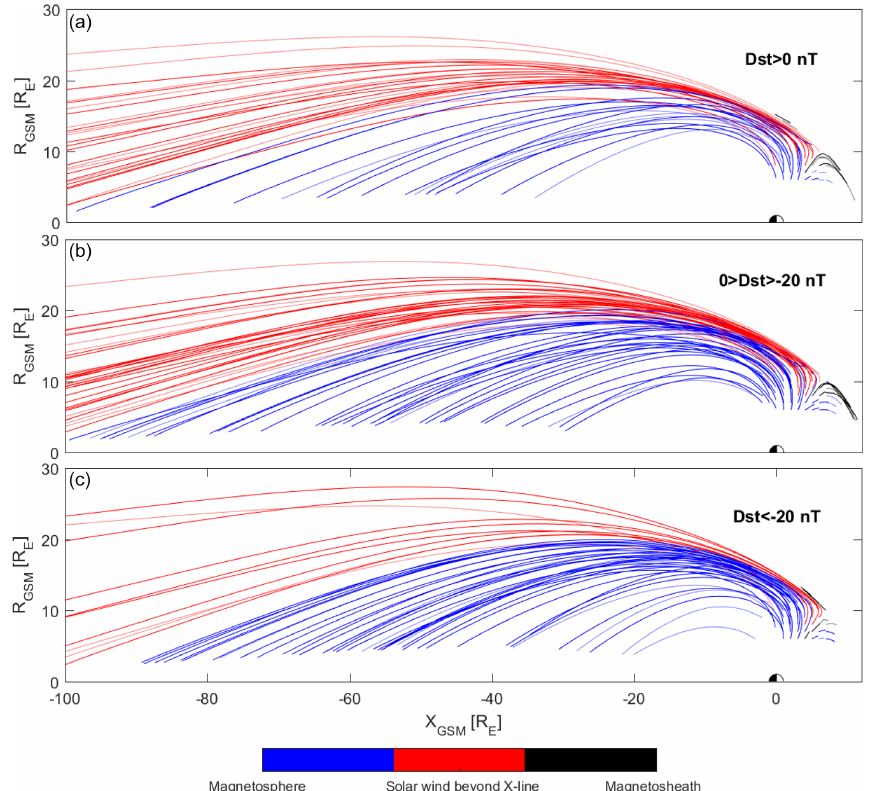
Figure 10. The tracing results using parallel initial velocities for different storm conditions. Panel (a) shows quiet conditions, panel (b) shows moderate storm conditions, and panel (c) shows active storm conditions. The colors are the same as in Fig. 8.